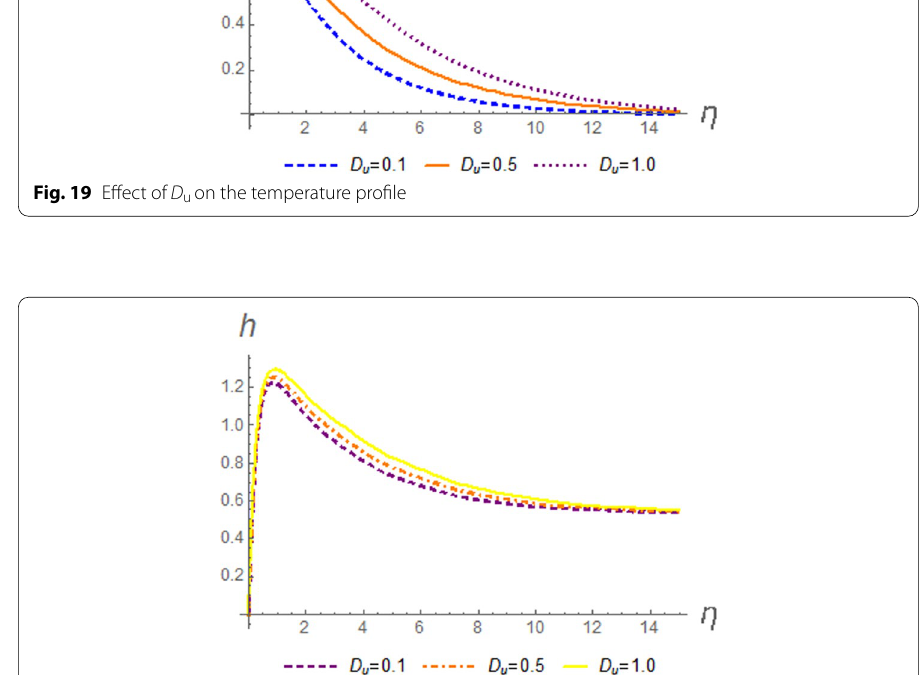
Fig. 20 Effect of D u on the velocity